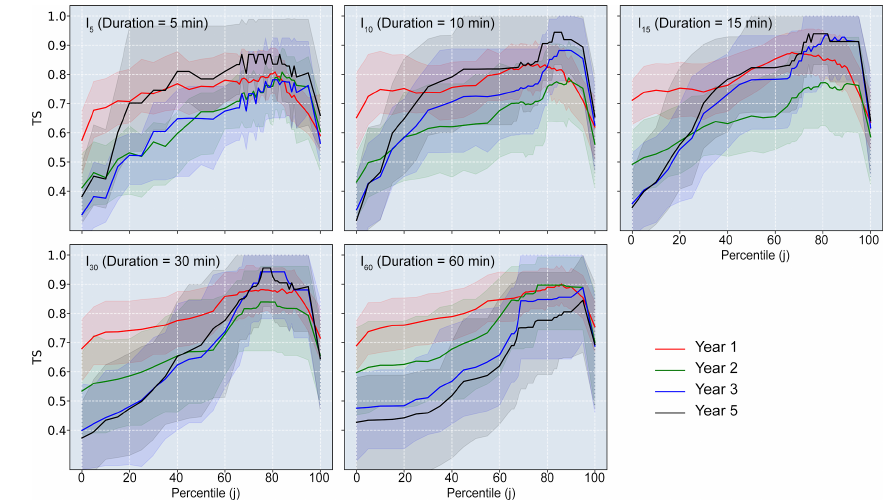
in post-fire years 1, 2, 3, and 5. Data used to analyze are from D